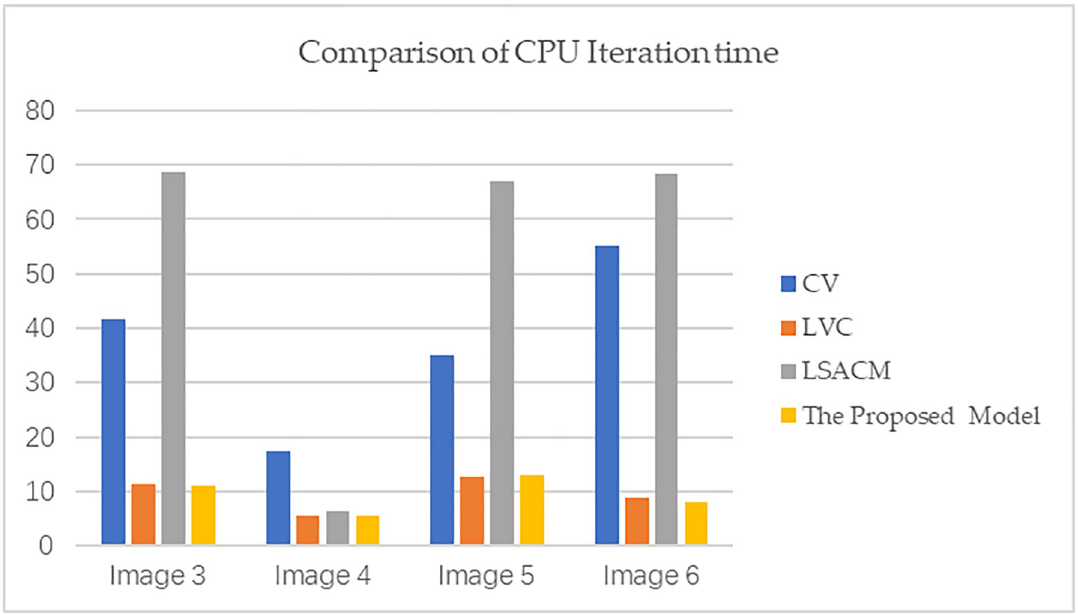
Fig 7. Comparison of CPU iteration time of the proposed model with CV, LVC and LSACM.